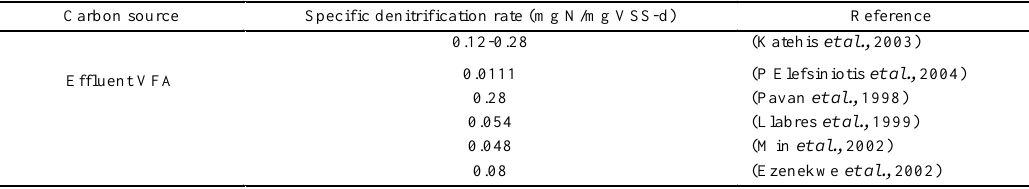
Table 6: SDNR results reported in previous studies